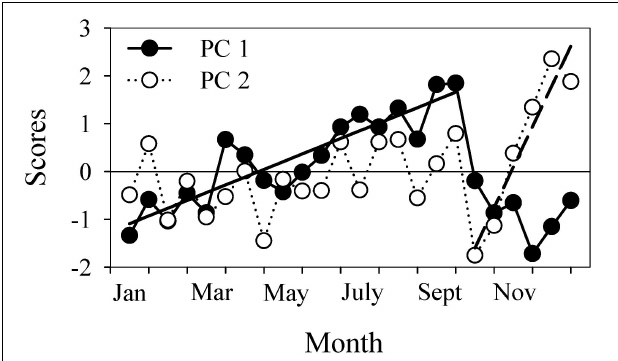
FIGURE 8 | Time series of the scores of the first (PC 1) and second (PC 2) components extracted by principal component analysis with the biomasses of the microbial plankton groups. The continuous line shows the seasonal increase in biomass in all plankton groups as revealed by PC 1: Y = (–1.25 ± 0.21) + (0.16 ± 0.02)X; r 2 = 0.81; n = 18, p < 0.0001. The dashed line displays the biomass increase in picophytoplankton and pico-and nano-heterotrophs (HPF and HNF) at the beginning of a new growth season, as depicted by PC 2: Y = (–17.67 ± 2.95) + (0.85 ± 0.14)X; r 2 = 0.91; n = 6, p =